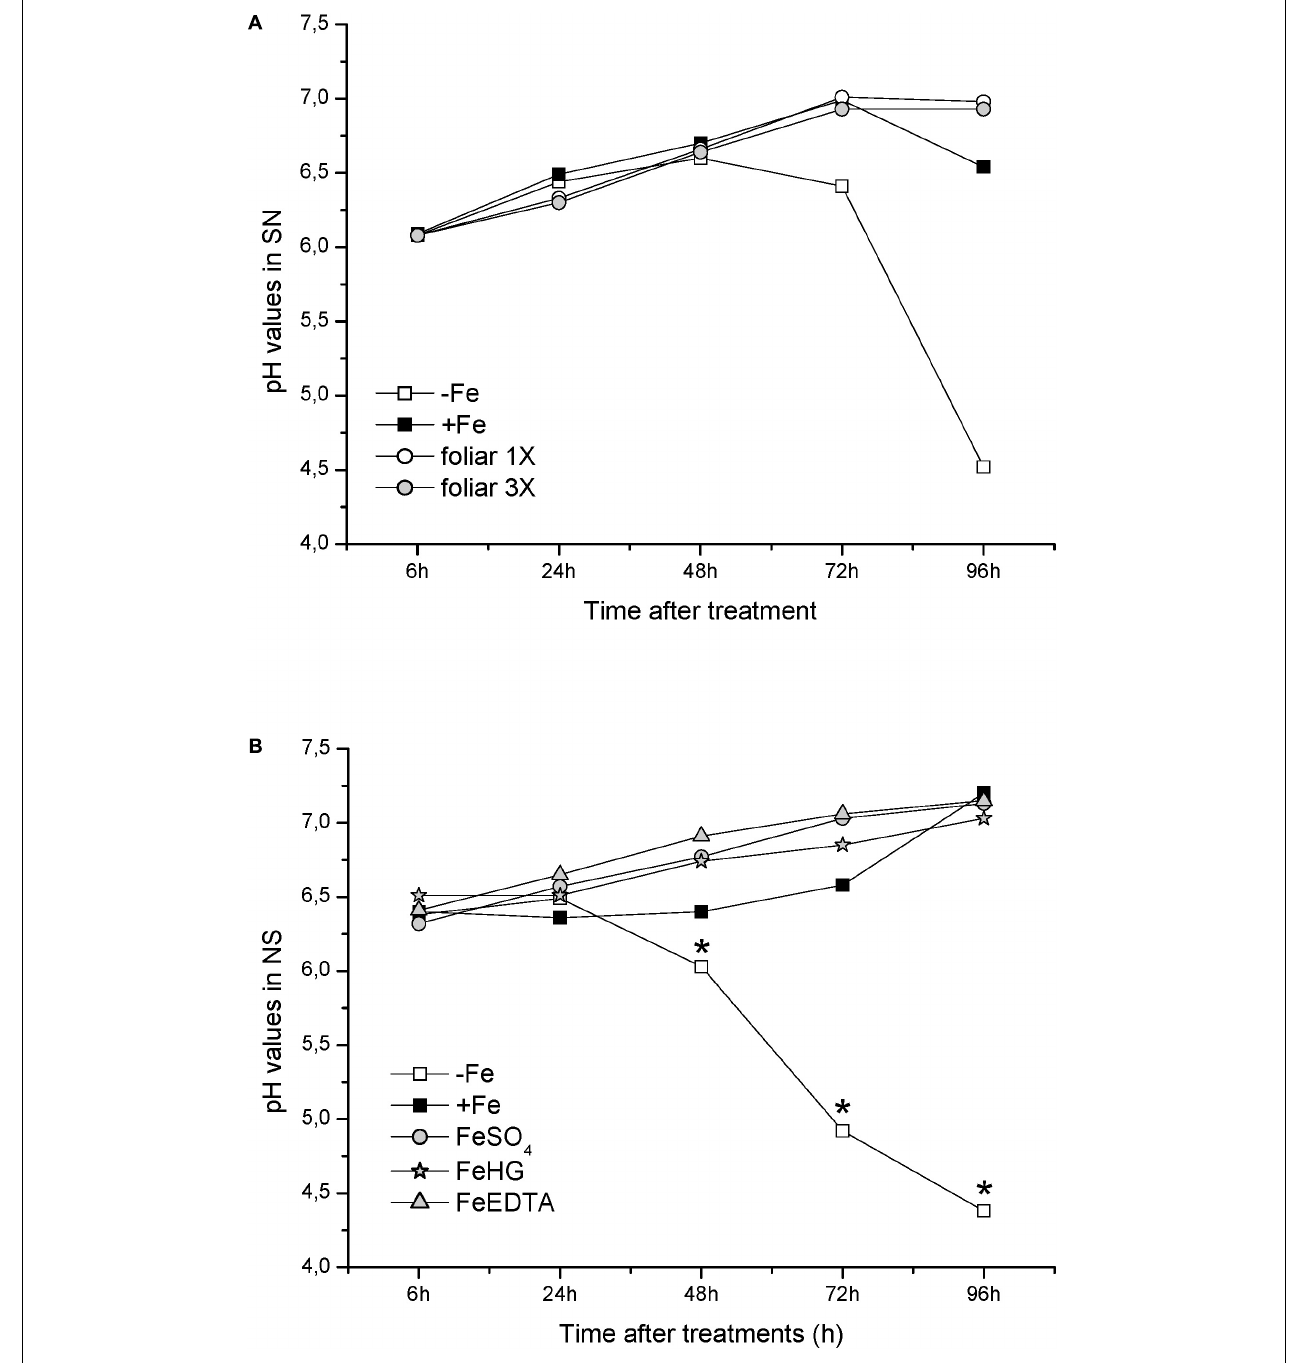
FIGURE 1 | pH values measured in nutrient solution from: (A) Experiment I and (B) Experiment II. Data are means ± SE ( n = 5). Asterisks indicate significant differences between treatments at P < 0.05 based on one-way ANOVA and Fisher’s post hoc test.